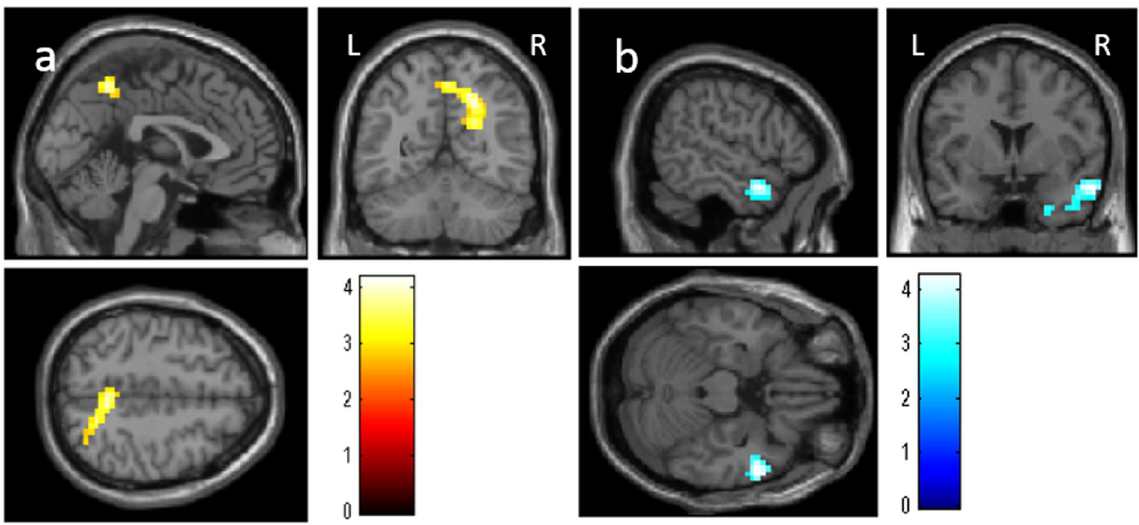
Figure 4. Changes in regional homogeneity in the working memory training (WMT) group compared with the control group. ( a ) Results are shown with a threshold of P < 0.05 and were corrected for multiple comparisons at the cluster size with an underlying uncorrected voxel-level of P < 0.005. The three panels show WMT-related increases in regional homogeneity. ( a ) Increases in regional homogeneity in the WMT group compared with the control group; Compared with the no intervention (control), WMT resulted in significant increases in regional homogeneity in the anatomical cluster that included the precuneus, posterior cingulate cortex, and the right posterior parietal cortex. ( b ) Decreases in regional homogeneity in the WMT group compared with the control group; Compared with the control intervention (no intervention), WMT resulted in a significant decrease in regional homogeneity in the anatomical cluster that included the area around the right temporal pole.